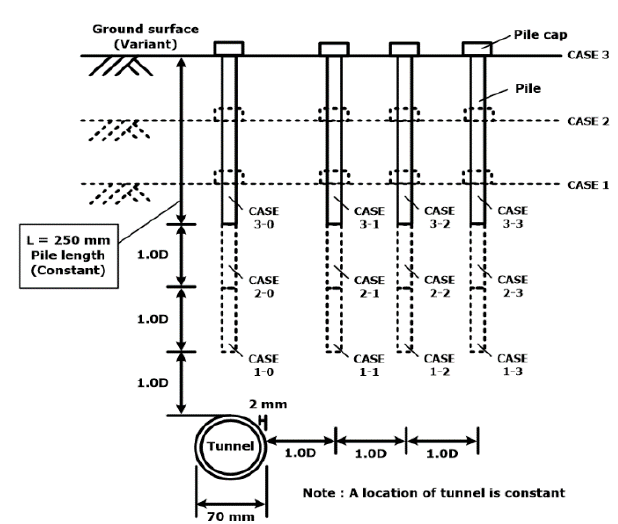
Figure 11. Cases for model test in this study.